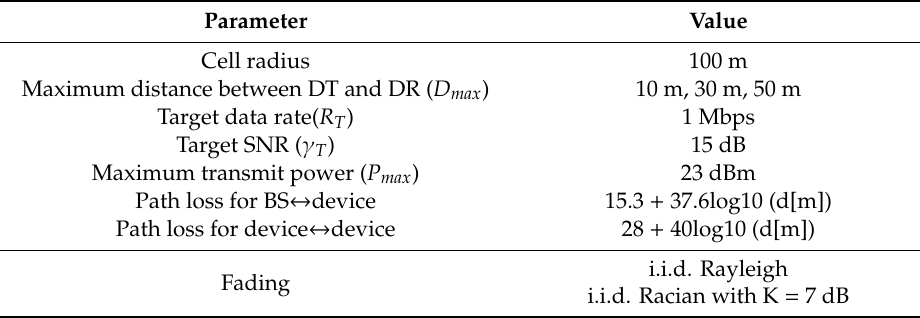
Table 1. Simulation parameters.